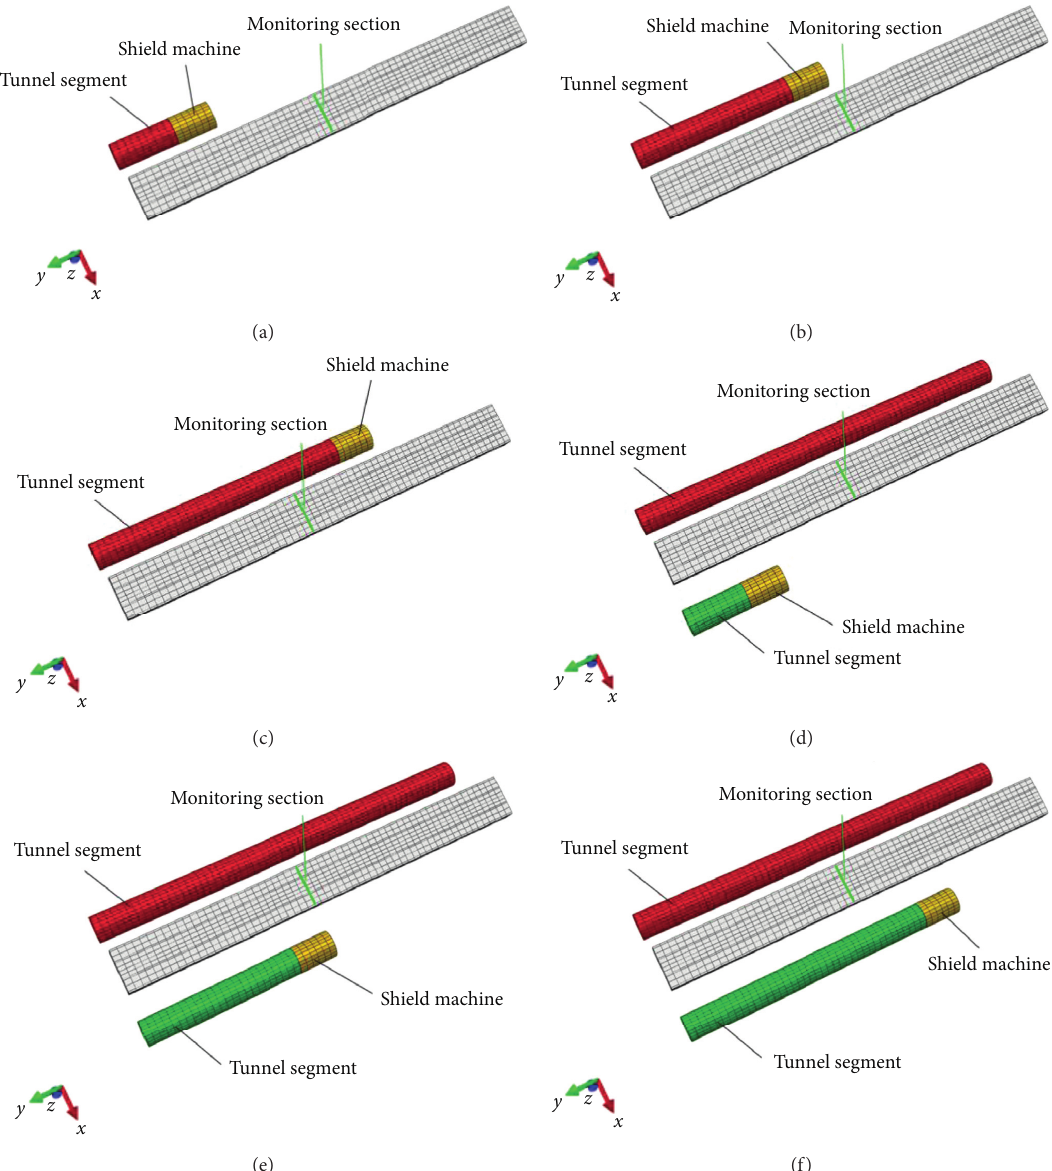
Figure 12: Relative position of the shield machine and utility tunnel at the selected moment of monitoring. (a) Left lane to 15th ring. (b) Left lane to 30th ring. (c) Left lane to 45th ring. (d) Right lane to 15th ring. (e) Right lane to 30th ring. (f) Right lane to 45th